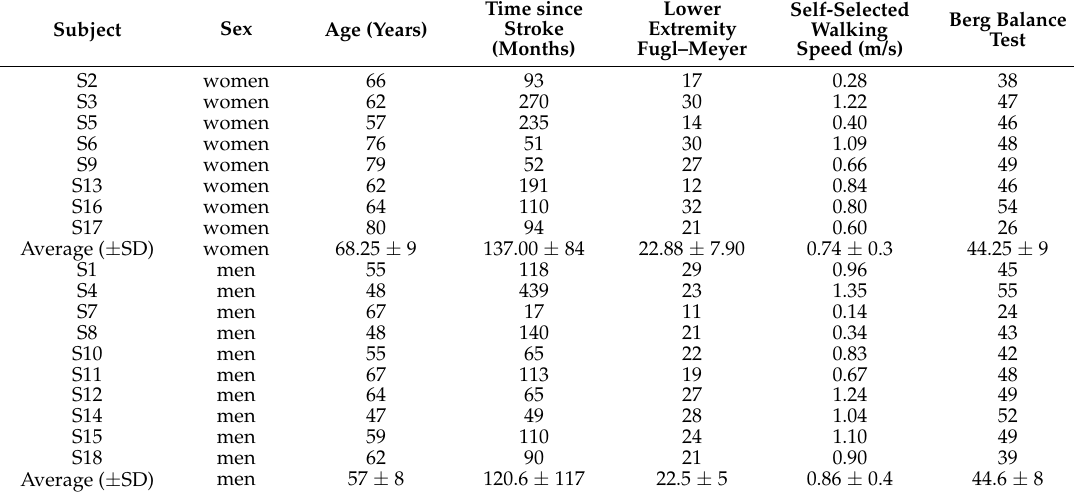
Table 1. There was not a statistically significant difference in function between the women and men stroke subjects ( p ≥ 0.4 for Lower Extremity Fugl–Meyer, Self-Selected Walking Speed, and Berg Balance